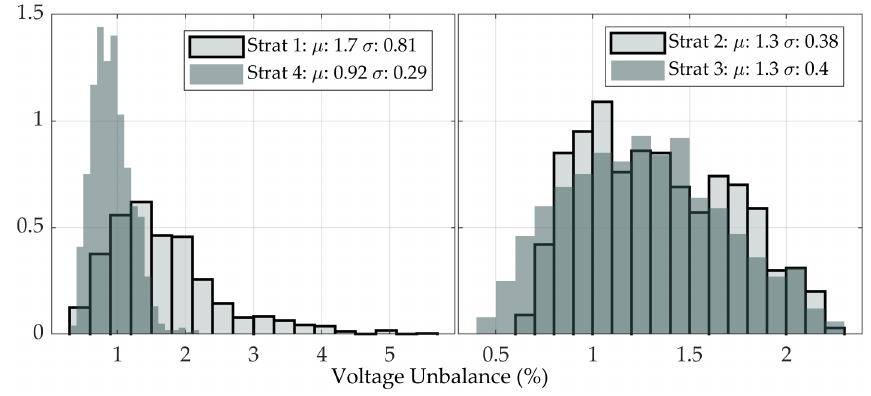
Figure 5. Voltage unbalance levels in rural